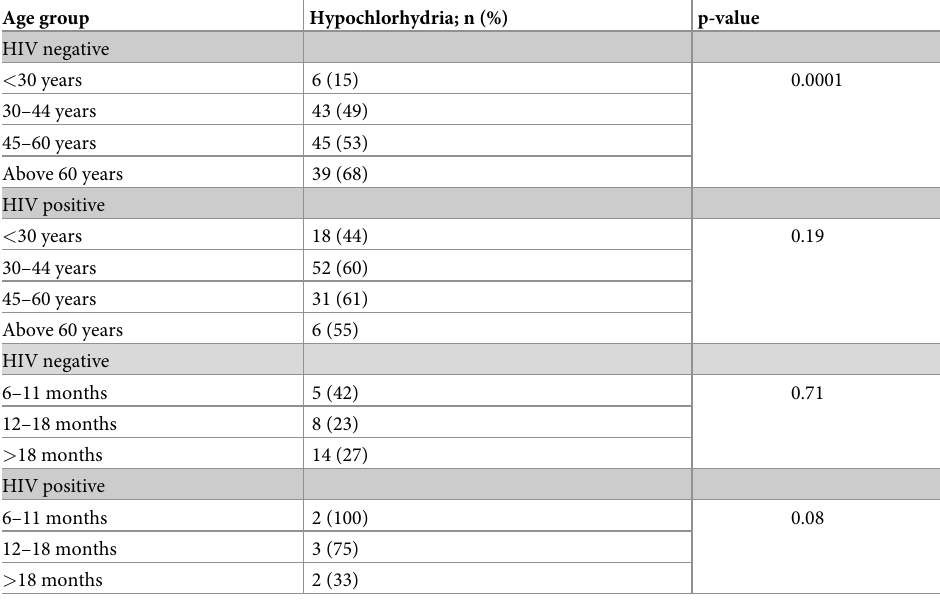
Table 2. Association between age and gastric pH in individuals with or without HIV infection. Age group